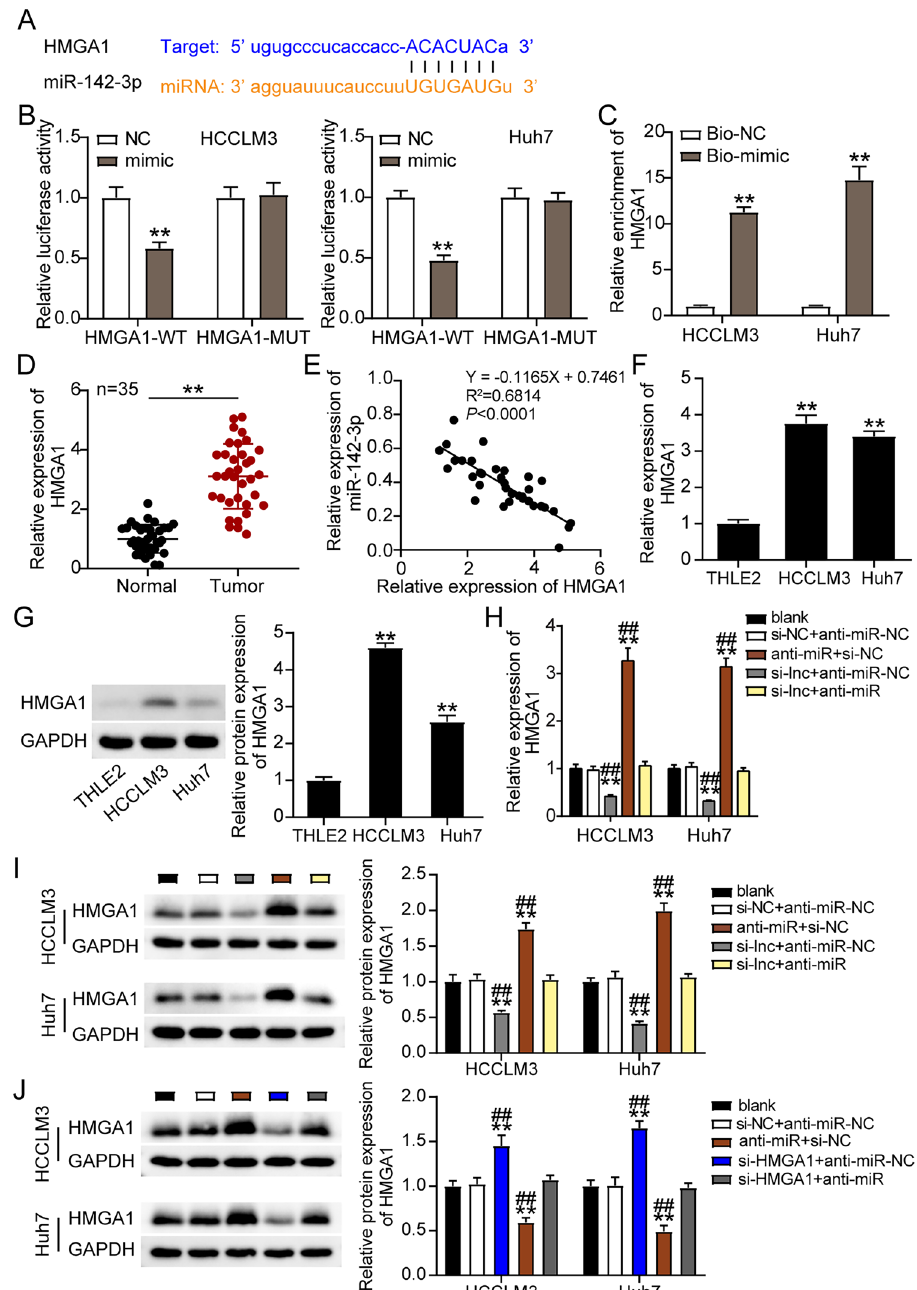
Figure 8. MiR-142-3p repressed the level of HMGA1 in LIHC cells. ( A ) StarBase prediction of binding sequences between HMGA1 and miR-142-3p. ( B ) Dual luciferase assay was measured in HCCLM3 and Huh7 cells. **P < 0.001 comparison with NC. ( C ) The enrichment of miR-142-3p, ST8SIA6-AS1 and HMGA1 was determined by RT-qPCR. **P < 0.001 comparison with Bio-NC. ( D ) RT-qPCR used for determination of HMGA1 expression in LIHC tissues. **P < 0.001. ( E ) In LIHC tissues, there is a negative connection between miR-142-3p and HMGA1. ( F ) HMGA1 expression was measured using RT-qPCR in LIHC cells (HCCLM3 and Huh7 cells) and normal cells (THLE2). **P < 0.001 comparison with THLE2. ( G ) HMGA1 expression was measured using western blot in LIHC cells (HCCLM3 and Huh7 cells) and normal cells (THLE2). **P < 0.001 comparison with THLE2. ( H ) HMGA1 mRNA expression measurement in transfected Huh7 and HCCLM3 cells. ( I ) Expression of the HMGA1 protein in transfected Huh7 cells and HCCLM3 was estimated. **P < 0.001 comparison with blank; ## P < 0.001 comparison with si-lnc + anti-miR. NC: negative control; Si-lnc: SiRNA- ST8SIA6-AS1; anti-miR: miR-142-3p inhibitor; Si-lnc + anti-miR: SiRNA-ST8SIA6-AS1 + miR-142-3p inhibitor. ( J ) Measurement of HMGA1 expression in HCCLM3 and Huh7 cells was detected by western blot. ## P < 0.001 compared with si-HMGA1 + anti-miR; **P < 0.001 compared with blank. NC: negative control; blank: blank control, MUT: Mutant; WT: wild-type; Si-HMGA1 + anti-miR: SiRNA-HMGA1 + miR-142-3p inhibitor, and anti-miR: miR-142-3p inhibitor; Si-HMGA1: